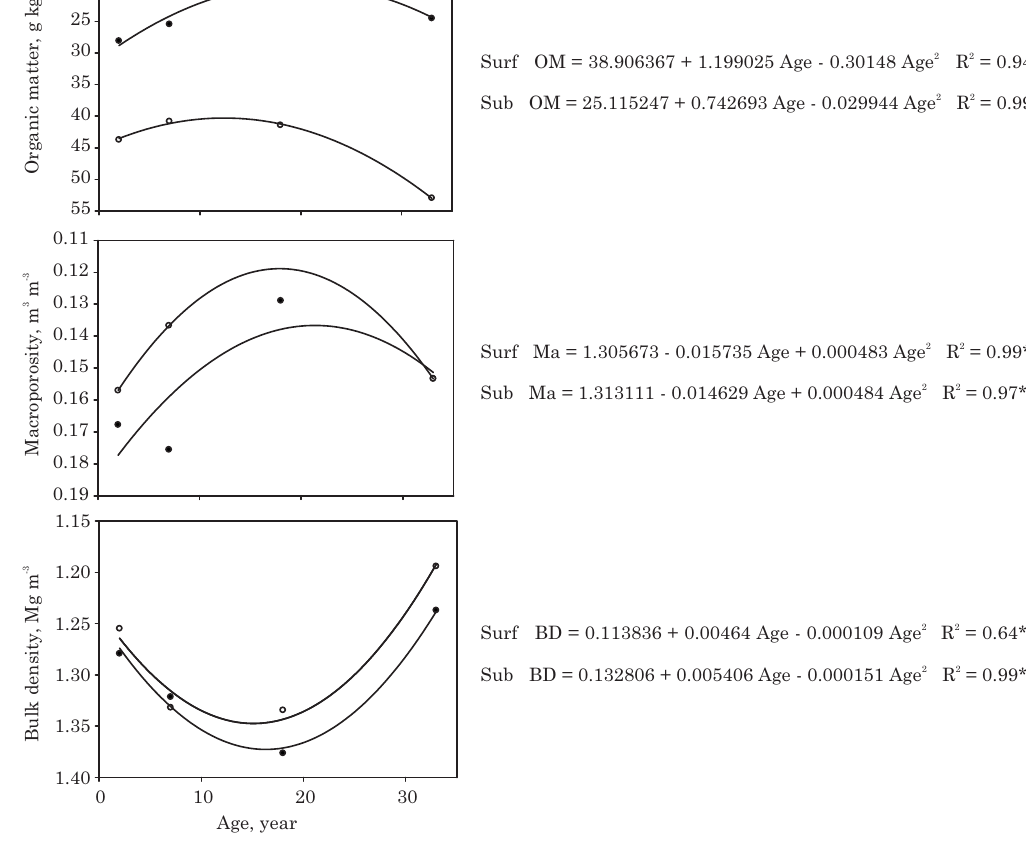
Figure 4. Effect of the interaction between age and depth on organic matter, macroporosity and bulk density (data are means of all three slopes and three sampling positions). lllll Surface layer and Sub-surface.